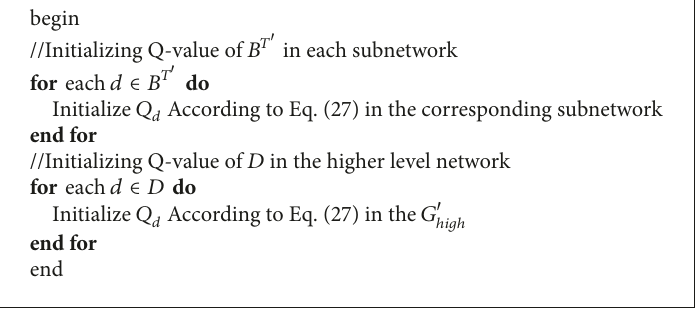
Algorithm 3: Procedure of Initialization.